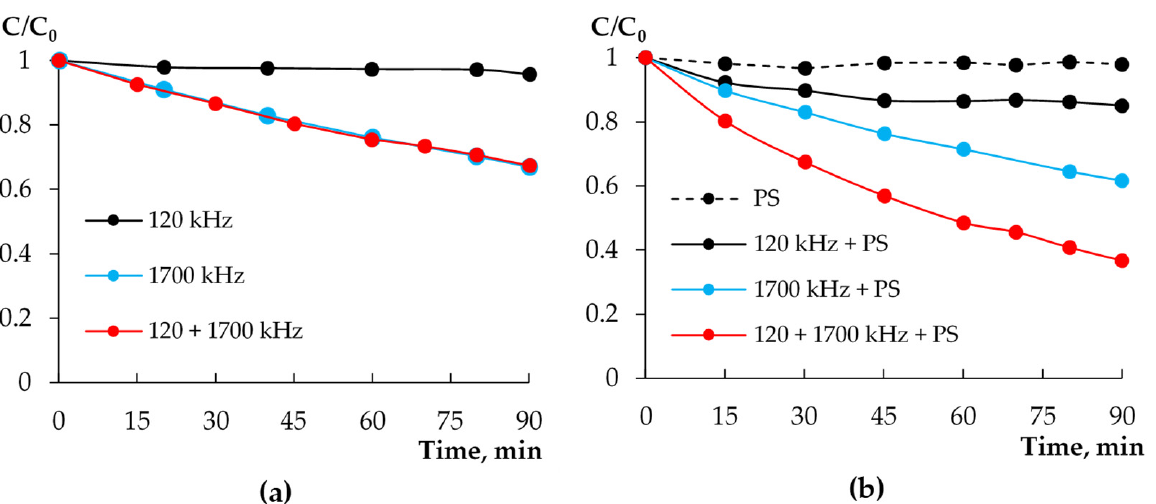
Figure 4. p CBA degradation by single- and dual-frequency ultrasound in the absence ( a ) and presence of persulfate ( b ). [ p CBA] 0 = 20 μ M, [PS] 0 = 200 mg/L.